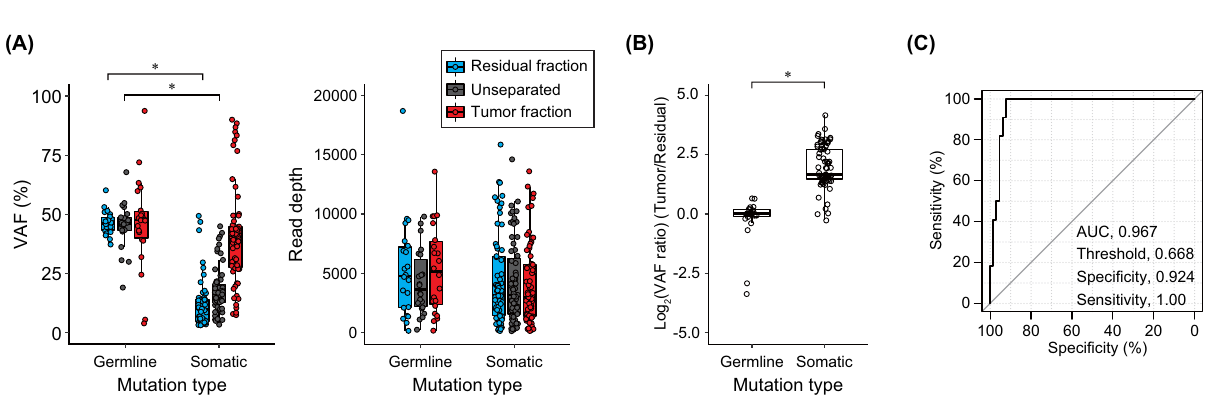
Figure 5. Characteristics of germline and somatic mutations in the separated and unseparated samples. ( A ) Distribution of variant allele frequency (VAF) and read depth. The genomic variations identified by whole- exome sequencing of the peripheral blood are defined as germline mutations, and the others are defined as somatic mutations. The germline mutation represents mutations found in the blood and the variant that were excluded because of their presence in the databases. ( B ) Ratio of VAF (tumor/residual) in mutations shared in all the fractions including the unseparated sample. For logarithmic transformation, the ratio is expressed as 0 when there is no change (VAF ratio = 1.0). Asterisk represents the significance ( p < 0.01). ( C ) Receiver operating characteristic (ROC) curve for estimation of germline and somatic